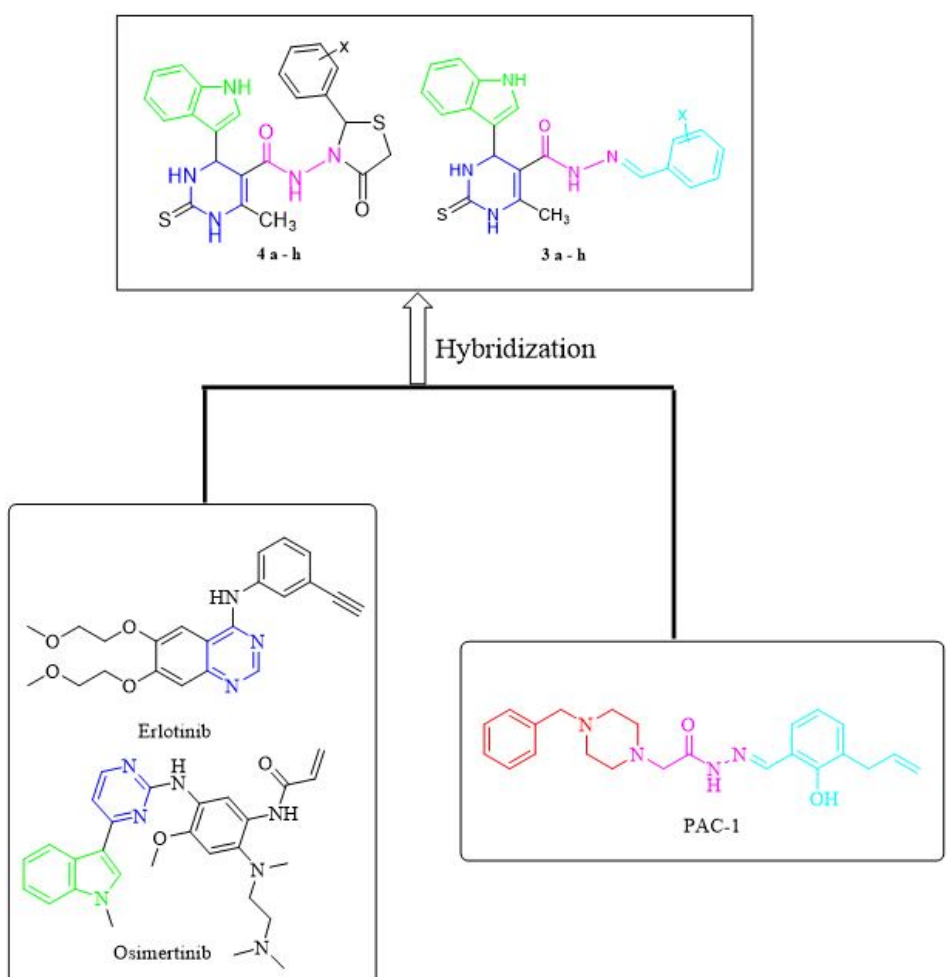
Figure 3. Rational design for the novel indolyl pyrimidine scaffold .